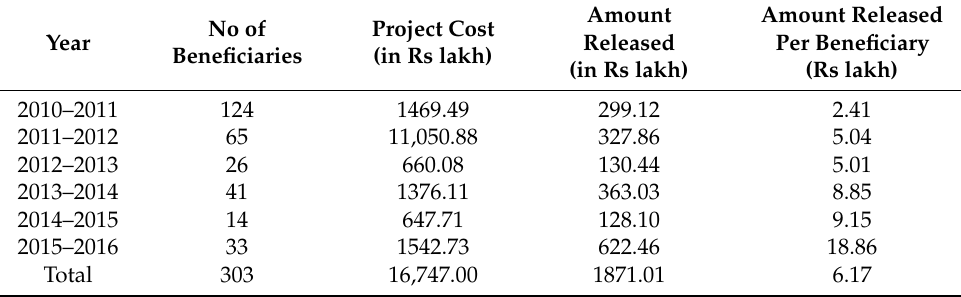
Table 6. Performance of National Horticulture Board scheme in